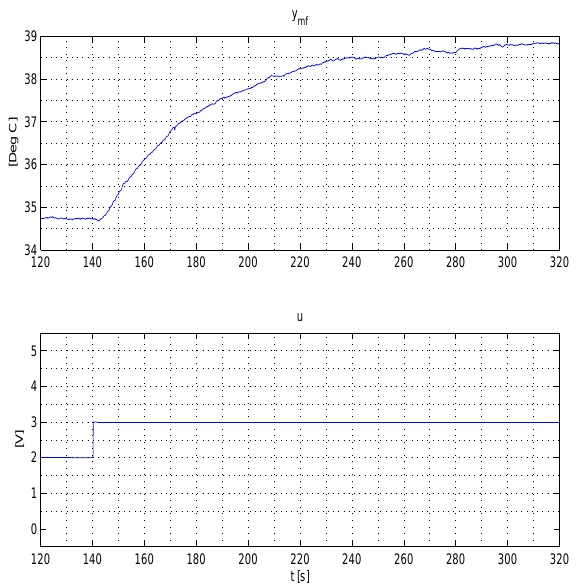
Figure 7: Open loop step response in filtered tempera- ture, y mf , due to a step in the heater control signal, u